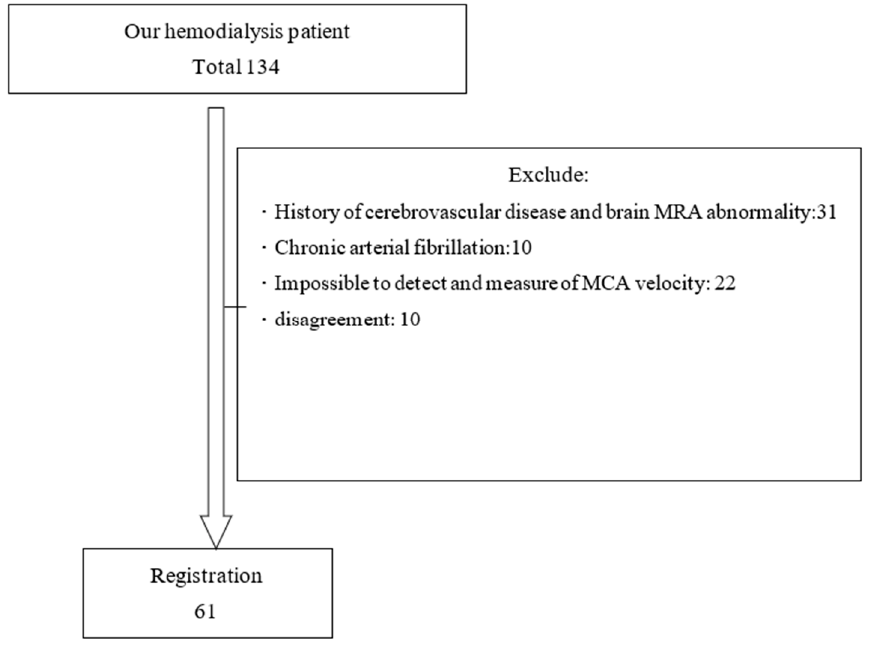
Figure 1. Patient